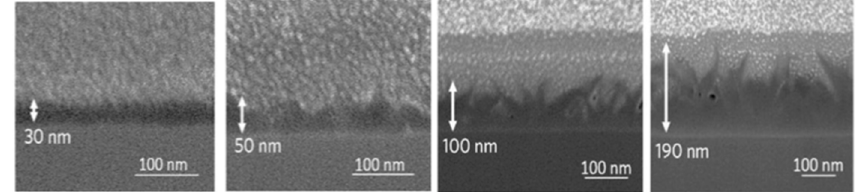
Figure 29. SEM images of VAGNAs at different CH 4 ratios using PECVD, showing the variation in thickness (reprinted with permission from [101]).